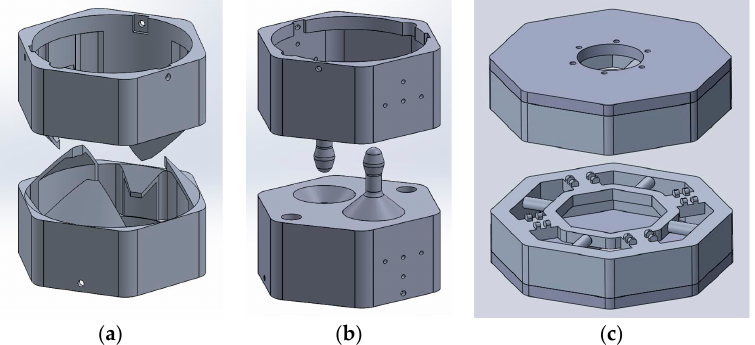
Figure 5. The three In-Orbit Attach Mechanisms designed for the project ( a ) based on the International Figure Docking System Standard (IDSS) [14]; ( b ) based on the Universal Docking Port (UDP) [16]; and ( c )